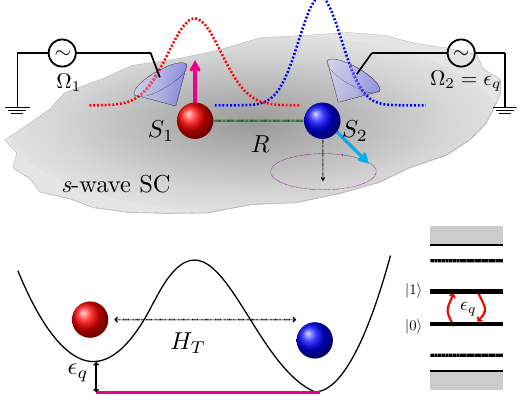
FIG. 1. The YSR qubit: two classical spins, target (red) and test (blue), are placed on top of a two-dimensional (2D) s -wave superconductor at a distance R , inducing a double-well poten- tial that accommodates two in-gap YSR states for a given parity. The odd-parity states | 0 (cid:4) and | 1 (cid:4) define the YSR-qubit states. The asymmetry of the potential stems from the slightly differ- ent coupling parameters at the two sites. The hybridization of the two YSR states is quantified by a tunneling Hamiltonian H T . Driving the test spin effectively tunes the potential bias and, when at resonance with the qubit splitting (cid:7) 2 = (cid:4) q , it allows for coherent rotations of the qubit. The target spin is interrogated off- resonantly at a frequency (cid:7) 1 (cid:5)= (cid:4) q for quantum